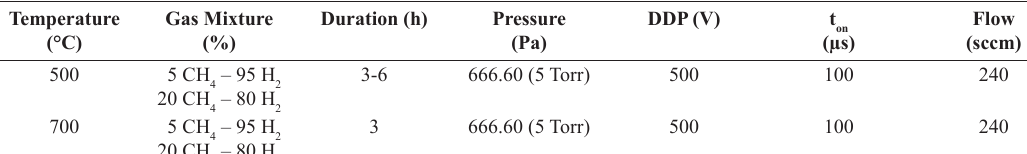
Table 2. The plasma carburizing conditions used in the study. Temperature (°C)